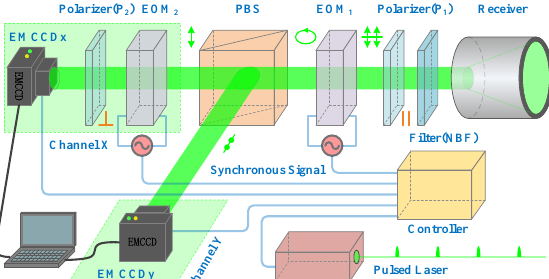
Figure 1. Polarization-modulated imaging framework. Here, the first electro-optic modulator (EOM1) manipulates the polarization state of the returned-light to perform time-resolved imaging, while the second modulator (EOM2) acts as a fast shutter for range-gated imaging. Dual electron multiplier charge coupled device (EMCCD) cameras acquire the polarization-modulated images for 3D reconstruction in channel X and Y, respectively. NBF, narrowband filter; PBS, polarization beam splitting.